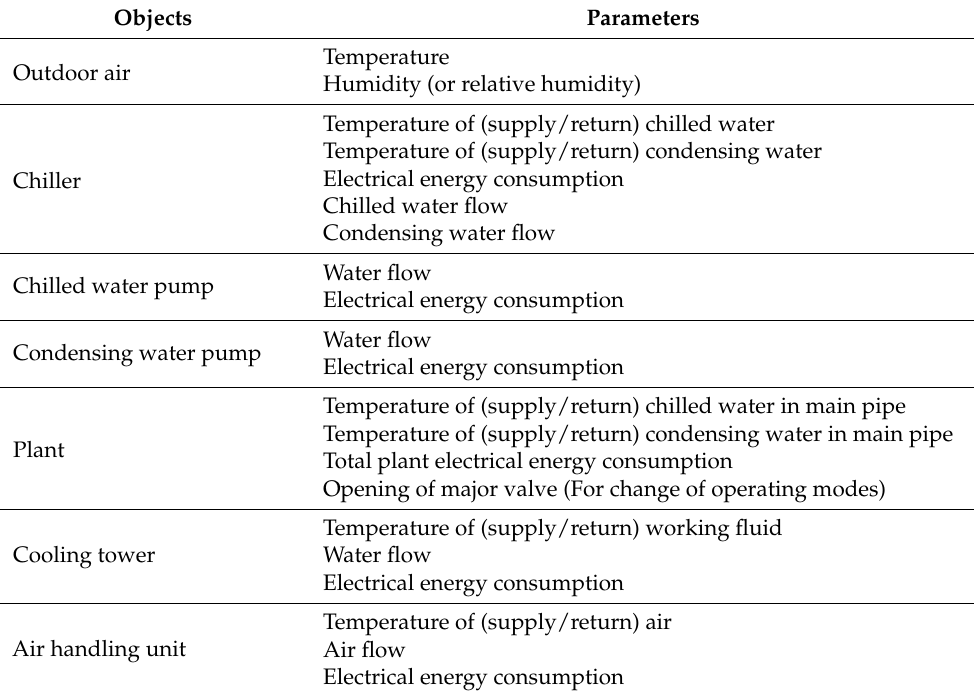
Figure 2. Schematic of a typical all-air air-conditioning system. Table 1. Data requirements for the data-mining based energy-saving potential analysis method.